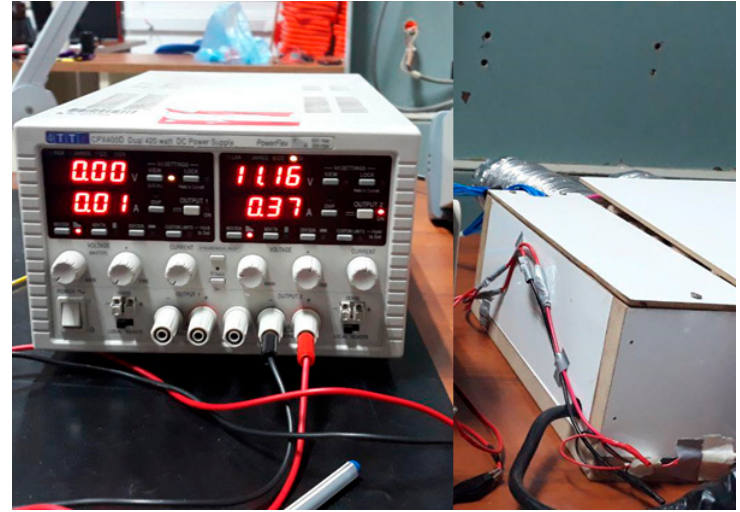
Figure 10. Controlling fan speed with the CPX400D power supply.